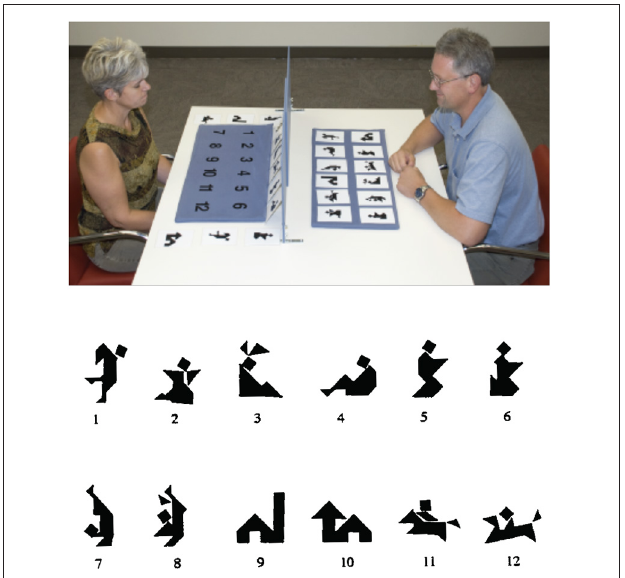
FIGURE 1 | Set up and tangram figures for Referential Communication